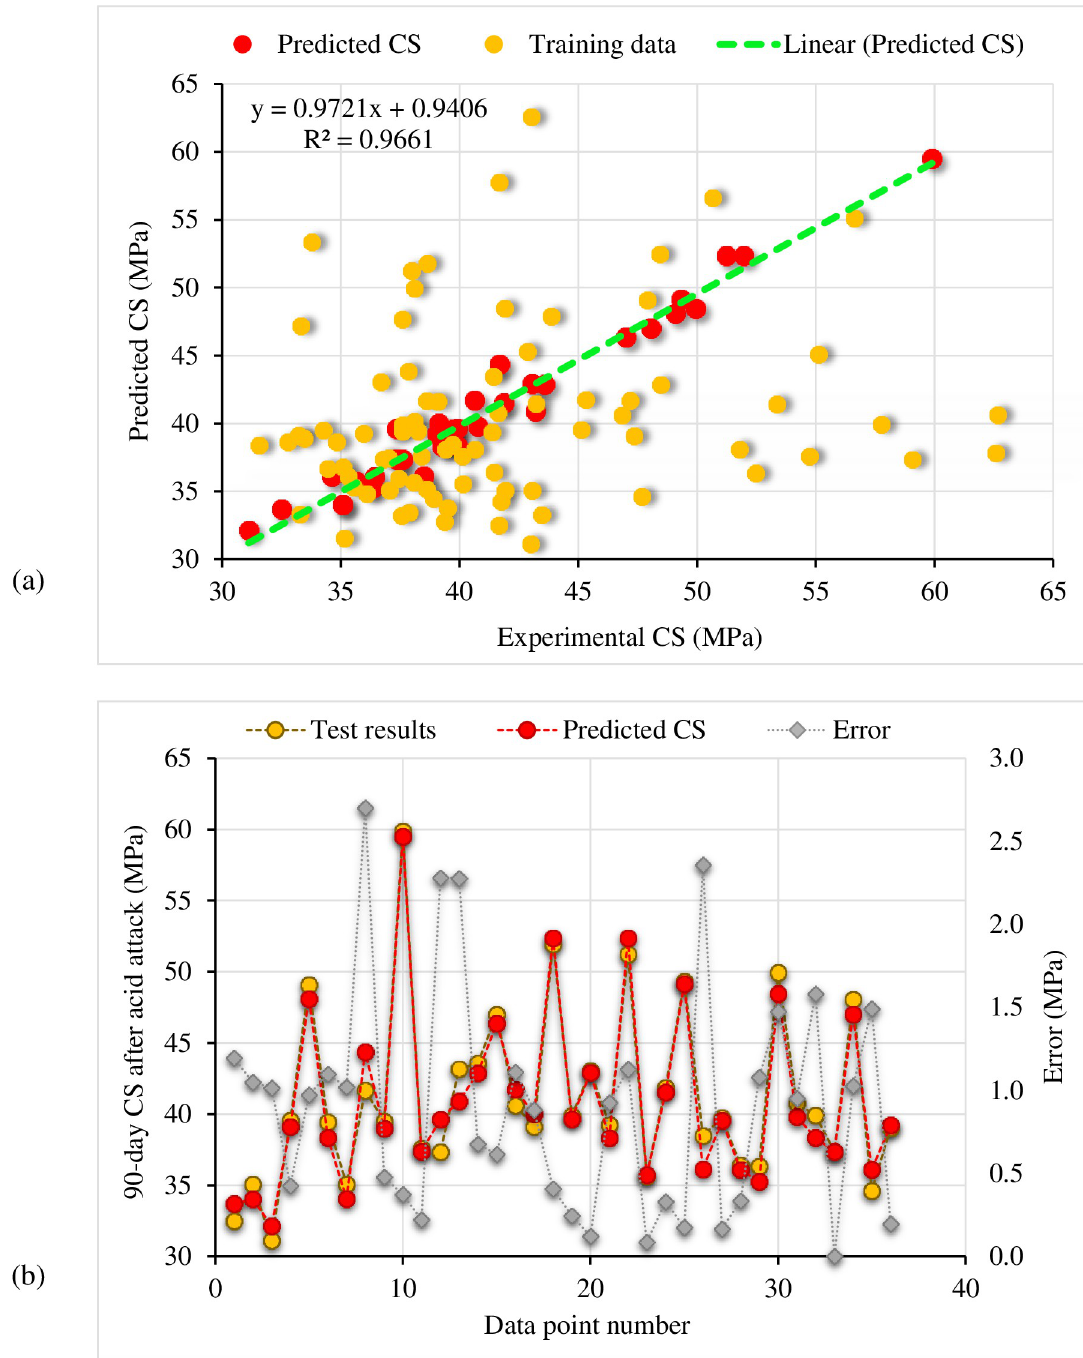
Fig 16. Bagging regressor model: (a) Correlation amongst experimental and predicted CS after the acid attack; (b) Representation of experimental, predicted, and error values. assaults. However, additional study is needed to assess RGP’s usefulness at higher replacement levels. Further, the lesser drop in CS of samples after acid attack indicated that the inclusion of RGP as a sand replacement was more valuable than its utilization as a cement replacement.